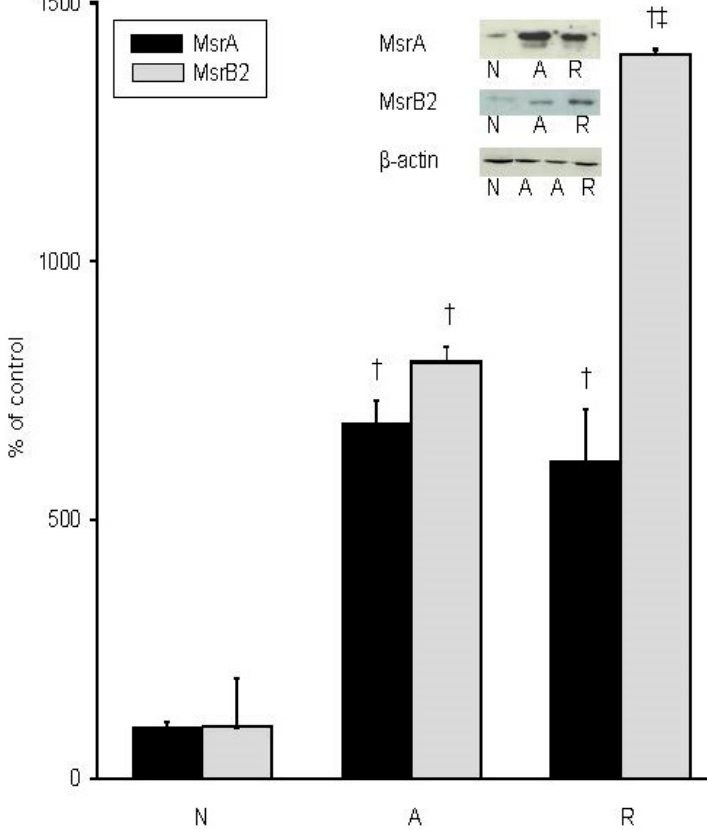
Figure 2. In vivo changes in Msr protein levels in the whole brain of T. scripta . Representative immunoblots of whole brain MsrA and MsrB2 proteins and actin control, and densitometric analysis of changes. N = normoxic controls, A = 4 h of anoxia, R = 4 h of anoxia/4 h of reoxygenation. Statistics: † = significantly different from normoxia; ‡ = significantly different from anoxia ( p < 0.001, n = 5 individuals/treatment).